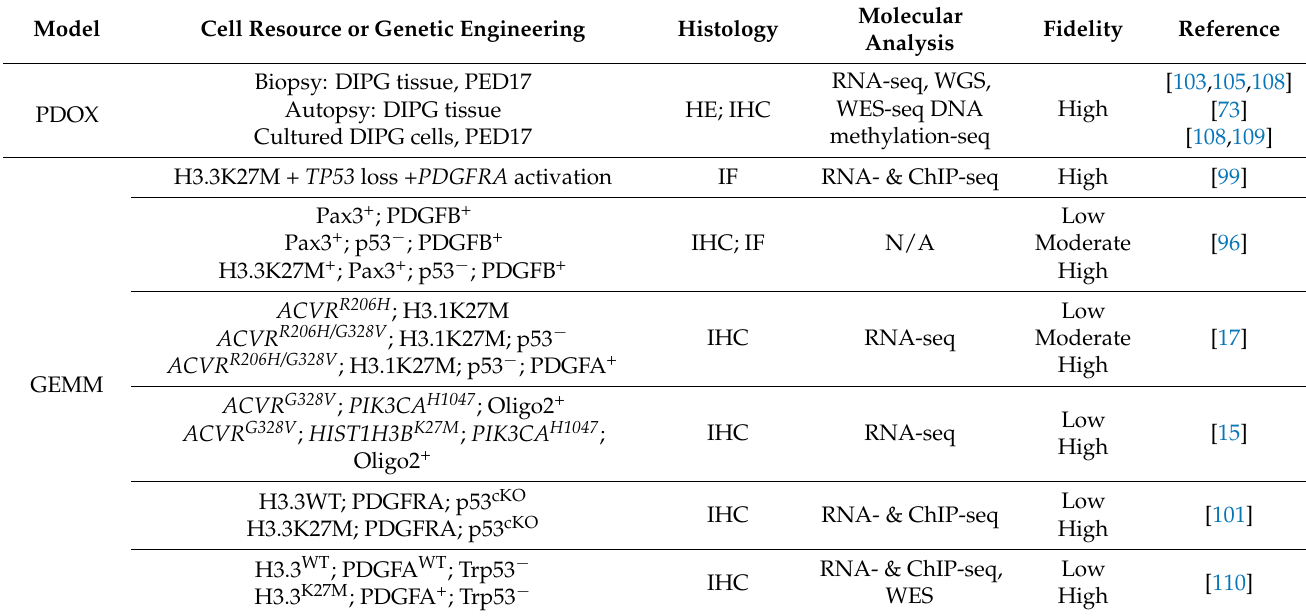
Table 2. Summary of PDOX and GEMM models’ fidelity and recapitulation of human DIPG, analyzed with histol- ogy/pathology and/or high-throughput characterization.